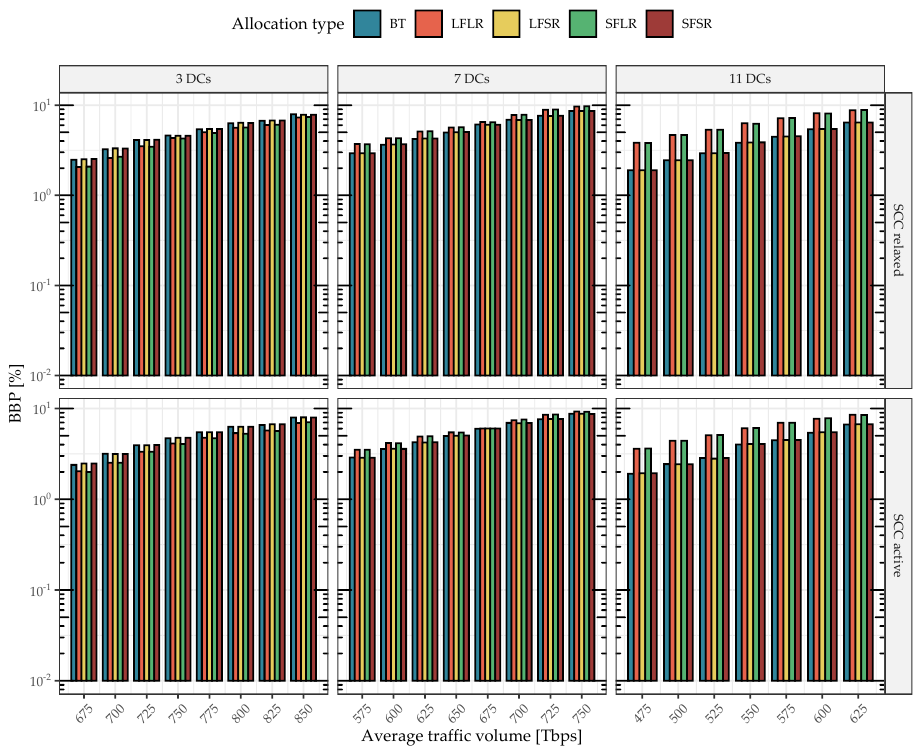
Figure 3. BBP as a function of the average traffic volume for various grooming strategies for the FF-TG